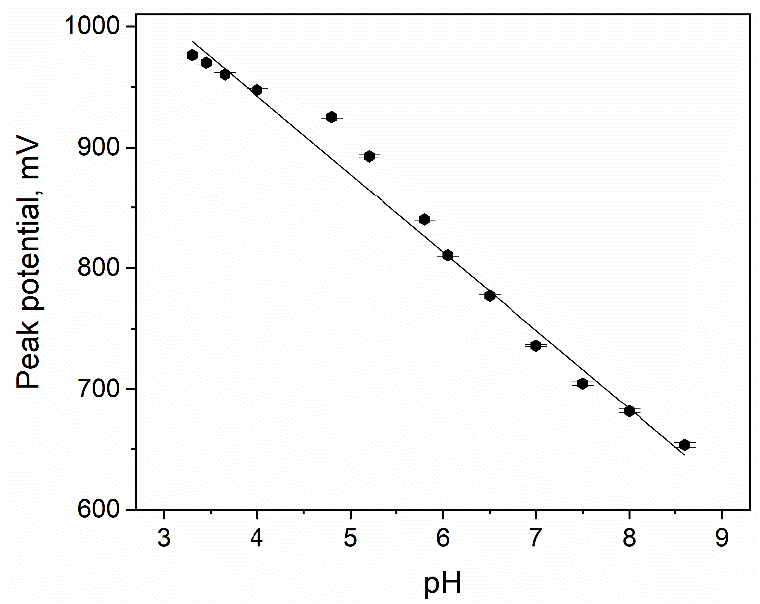
Figure 5. Dependence of pH of phosphate buffer (0.1 M) on CTZ peak potential.